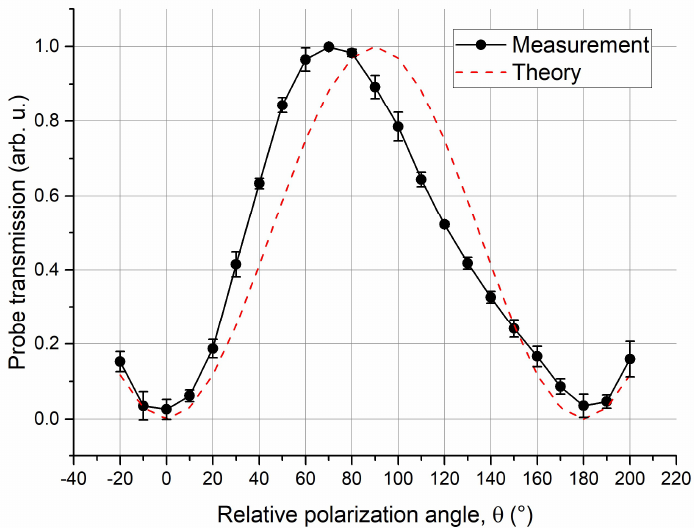
Figure 8. Probe transmission at zero coupling detuning ( ∆ c = 0) for different angles between the laser polarization and the RF E-field vector, where the solid line is the averaged result of multiple measurements and the related experimental standard deviation, and the dashed line represents the theoretical results.